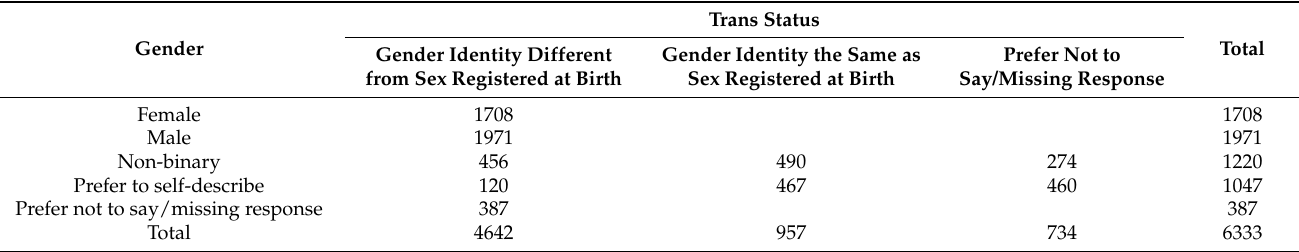
Table 2. Sample size: Trans and/or non-binary